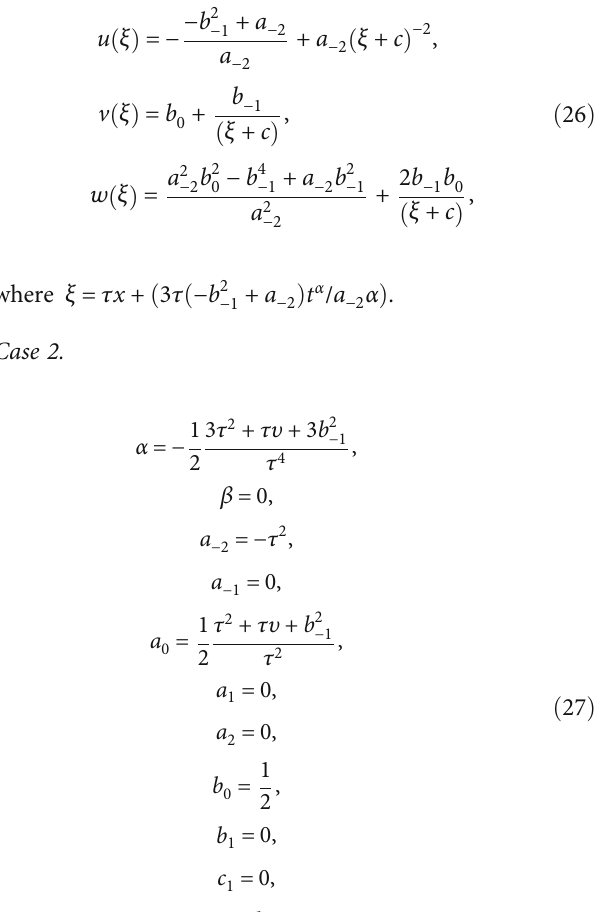
= τ = c = 1 and t = 1for different valuesof α 1 2